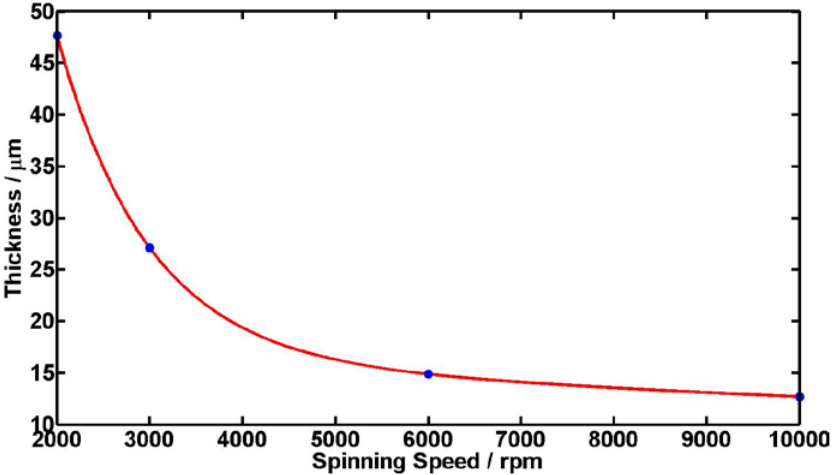
Figure 3. ORMOCOMP ® layer thickness as a function of angular